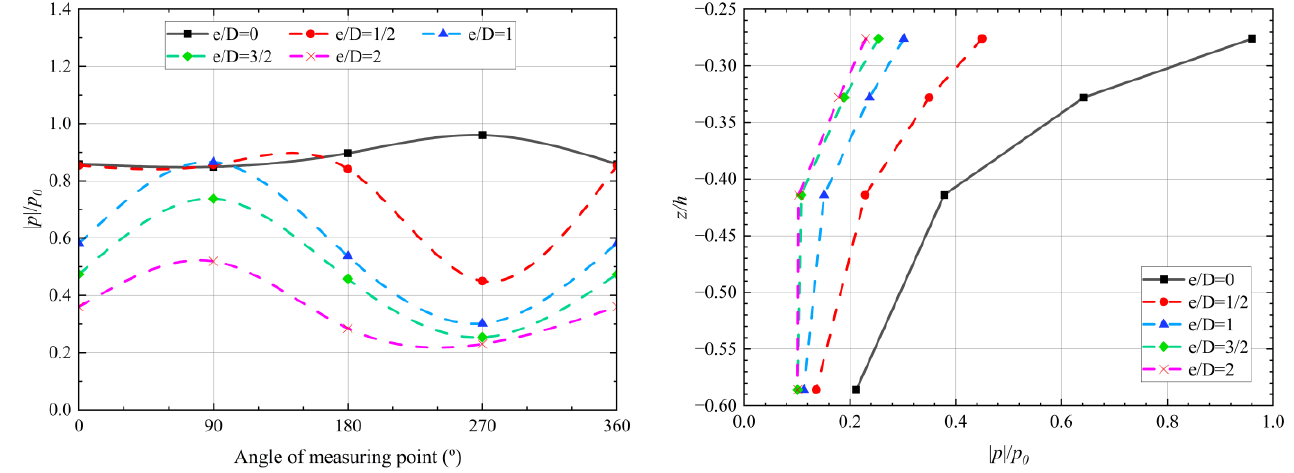
Figure 8. Variation of the dimensionless pore pressure amplitude around the pipeline with different backfill depths within the fine sand seabed.